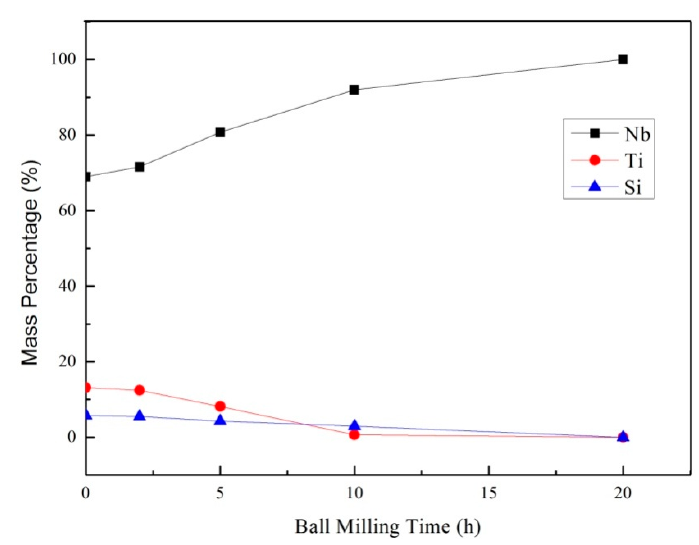
Figure 4. Evolution of the mass fractions of Nb, Ti and Si phases during ball milling, estimated by the standard RIR method.